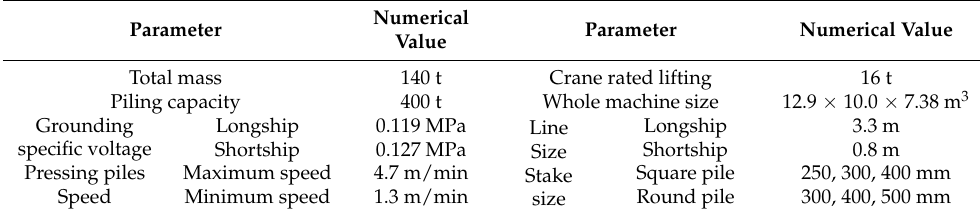
Table 1. YZY400 pile driver performance